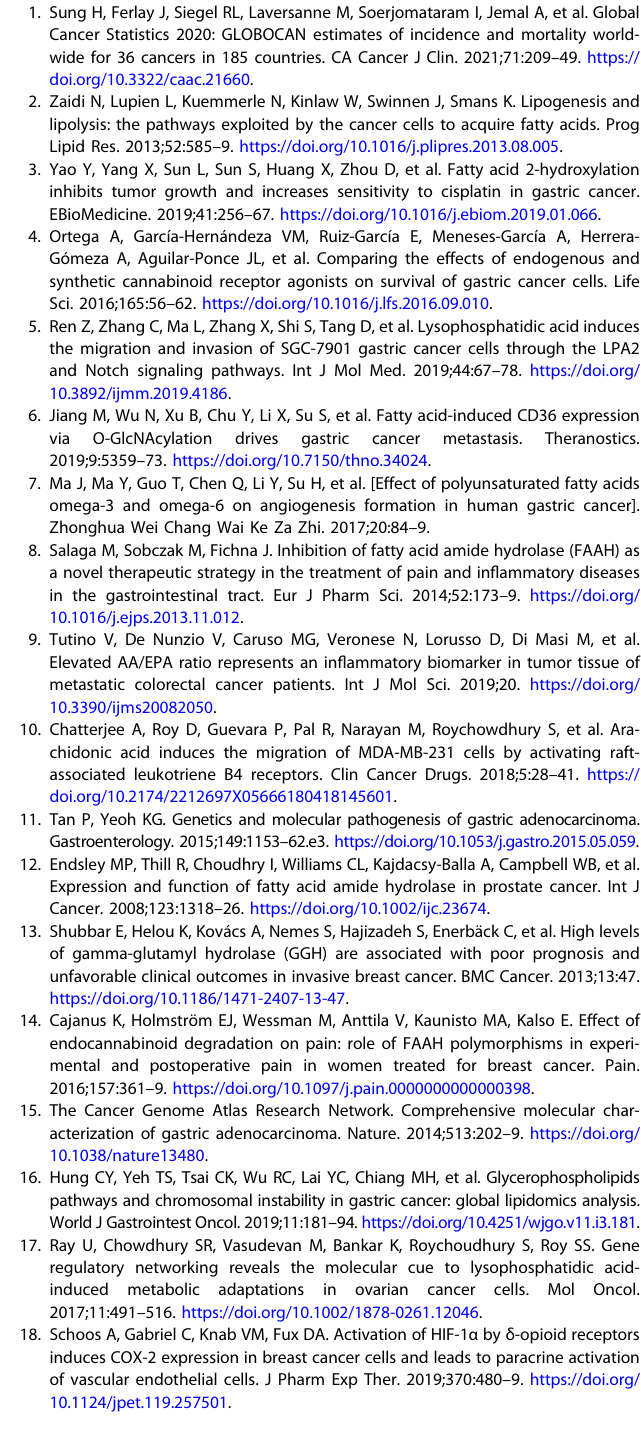
Fig. 6 miR-1275 targets FAAH to coordinate AEA/LPA signalling in GC. A GSEA analysis of FAAH and fatty acid metabolism (data from the gastric adenocarcinoma database in the TCGA). B Heatmap of differential lipid metabolites in negative ion mode after interference with FAAH. C The Volcano plots. D Bar graph of differential lipid metabolites after interference with FAAH. E The content of total PG, PGD2, PGE2, PGF2 α , and PGI2 in the cell supernatant was determined by ELISA after FAAH interference and overexpression. F Detection of changes in lipid signal involved in AEA/LPA pathway after interference with FAAH. G Content of total PG and PGE2 in the cell supernatant after treatment with miR- 1275 mimic or inhibitor. H Changes of lipid signal in AEA/LPA pathway after co-transfection of miR-1275 and FAAH vectors. I Schematic diagram. * p < 0.05, ** p < 0.01, *** p < 0.001. NES normalised enrichment score, FDR false discovery